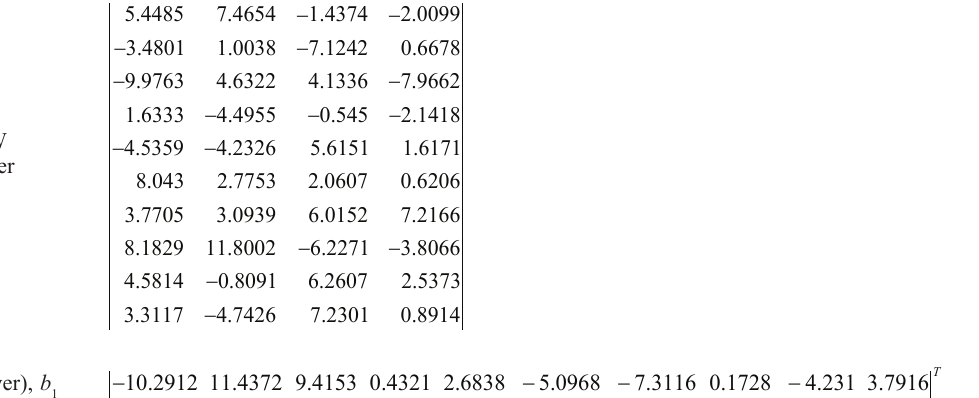
Input weight matrix, IW (Weights to Hidden layer from inputs)